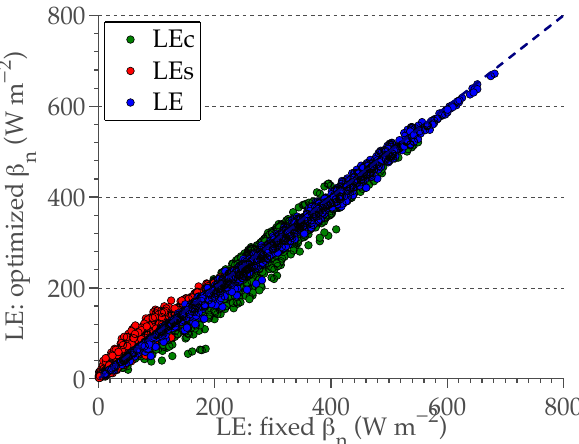
791 Fig. 7. Comparison of hourly modeled and measured energy balance components for maize and 792 Figure 7. Comparison of hourly modeled and measured energy bal- soybean at Mead, NE, generated with TSEB-LUE using 𝛽 ! as a function of Chl. 793 ance components for maize and soybean at Mead, NE, generated with TSEB-LUE using β n as a function of